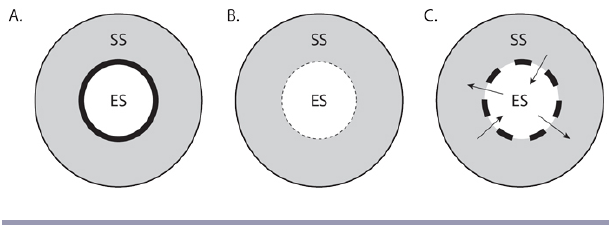
Fig. 1 . Marine protected area (MPA) types: (a) some MPAs effectively remove or minimize direct human influences on natural ecosystems by protecting remote areas or by strictly enforcing no-take/no-access regulations; (b) other MPAs are paper parks, where the human-natural interaction is not mediated by effective institutions; and (c) MPA Authorities or other institutions can act as effective mediators of the interaction between the social (SS) and the ecological systems